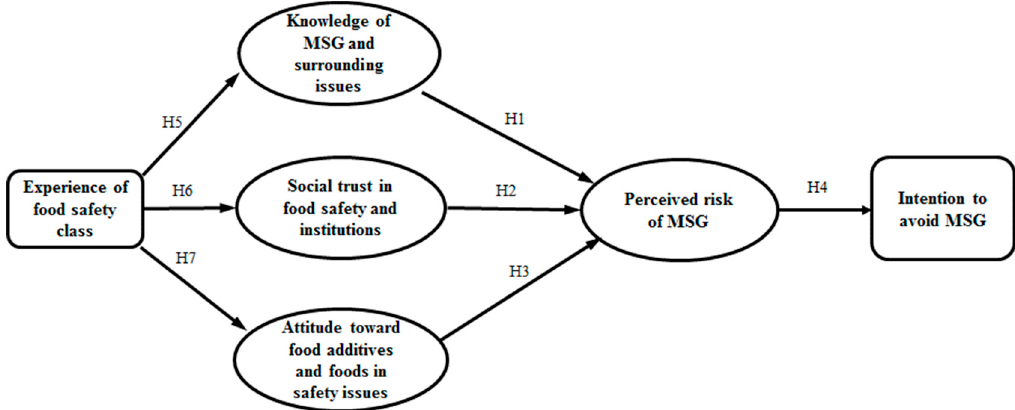
Figure 1. Specification of structural equation model.